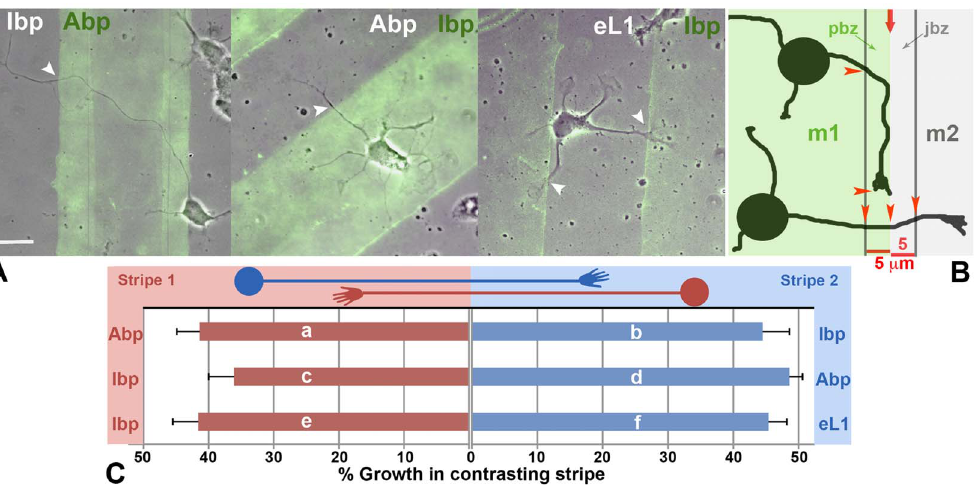
Figure 7. Substrate choice control assays. A. Wt neurons grown for 24 h on alternating lanes of the indicated synthetic substrates. The stripe deposited first was quenched with fluorescent BSA (green; superimposed TIRF and phase contrast images). White arrowheads point at neurite crossings from one substrate to the other. The neurites grew without substrate preference. Scale 20 m m. B. Cartoon to explain the border zone analysis. m1 and m2, matrix 1 and 2. The red arrow marks the border between them. Two bands, 5 m m wide, define the proximal (pbz) and juxtaposed (jbz) border zones. Arrowheads indicate measured axonal segments. C. Percent growth in juxtaposed stripe (border zone analysis). The frame of the bar graph identifies the substrate pairings, with ‘‘stripe1’’ and ‘‘stripe 2’’ deposited first and second, respectively. The cartoons of the neurons designate the position of their perikarya and growth directions. The bar (mean 6 s.e.) in the same color as the neuron indicates % growth in the juxtaposed stripe. Letters a to f refer to the numerical data and statistics in Tables 6 and 7.